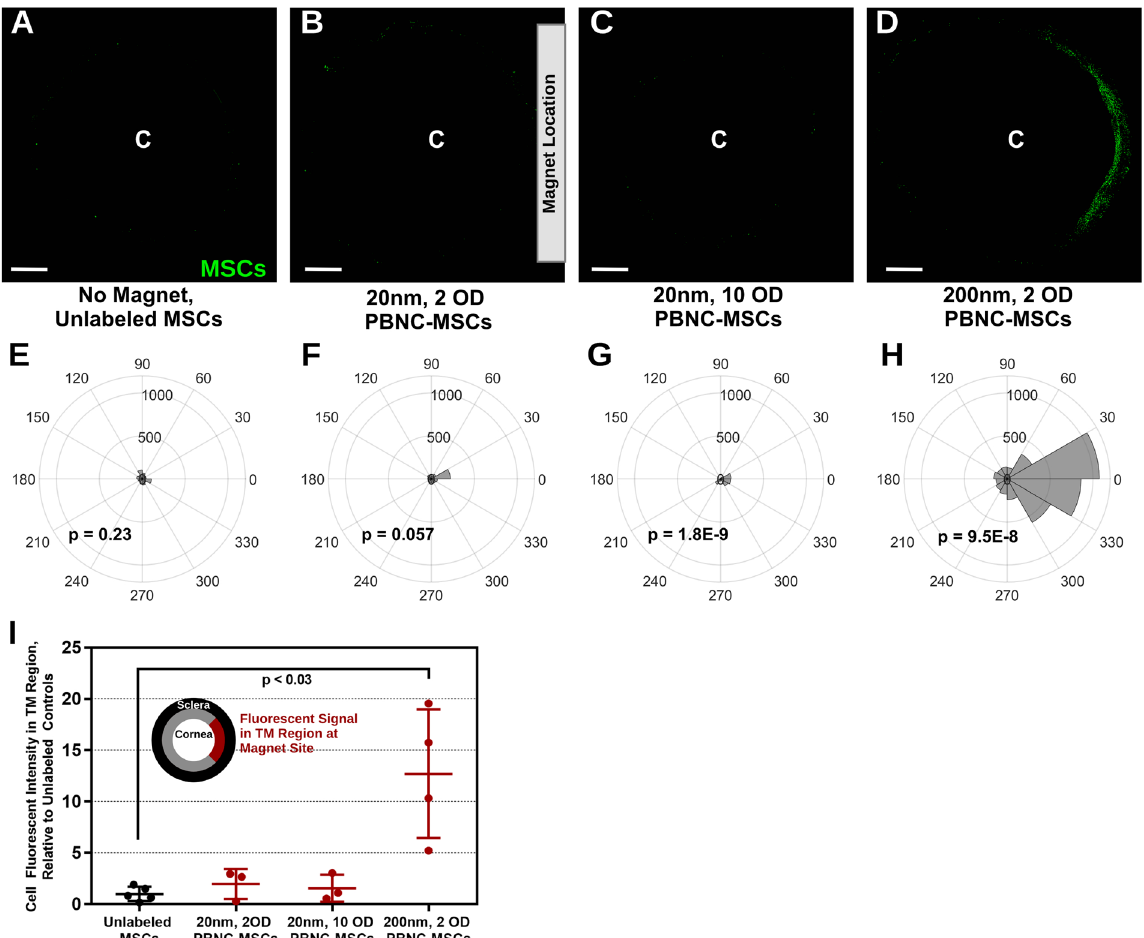
Figure 2. Magnetic Steering of MSCs labeled with either 20 or 200 nm PBNCs. (A–D) Representative en face micrographs of the anterior region of the eye after MSC delivery. Bar magnets, diagramed in (B) (to scale), were placed near the limbal region overnight in PBNC-MSC injected eyes. Cells that were steered to the TM appear as a green arc. “C” denotes the approximate center of the cornea. Note that the image has been masked so that only signal from the putative TM region is shown (see Methods). Scale bars denote 2 mm (E–H) The polar histograms illustrate the total fluorescence intensity within the TM region (plotted on the radial coordinate, in arbitrary units) for 30° sectors around the eye. Note that a bar magnet was placed adjacent to the limbus at 0° overnight. p-values were calculated using Kuiper’s V test to assess whether the distribution was non-uniformly skewed towards the center of the magnet location (0°). (A,E) no magnet, unlabeled MSCs (n = 5 eyes), (B,F) 20 nm, 2 OD PBNC-MSCs (n = 3 eyes), (C,G) 20 nm, 10 OD PBNC-MSCs (n = 3 eyes), and (D,H) 200 nm, 2 OD PBNC-MSCs (n = 4 eyes) experiments are shown. (I) Quantification of total fluorescent signal in the TM adjacent to the magnet (defined as the wedge extending from 45° to − 45°) relative to total fluorescent signal adjacent to the magnet from eyes injected with MSCs lacking PBNC labeling. Individual data points are shown with central bars indicating mean values and error bars denoting standard deviation. Significance (p < 0.05) was determined by Kruskal-Wallis test, with Dunn’s post hoc